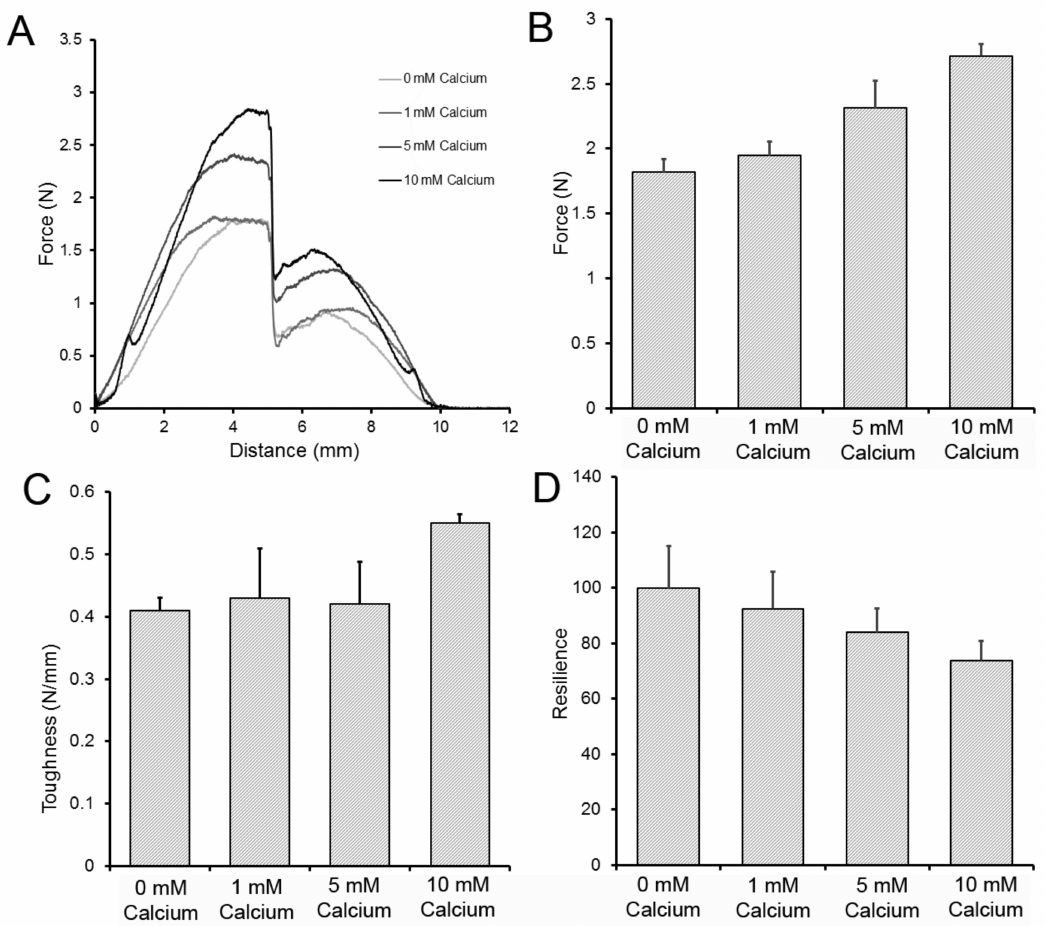
Figure 5. E ff ect of the calcium concentration on LMP film 3-point bend testing. ( A ) Representative 3-point bend tracings of LMP films with 0, 1, 5, and 10 mM calcium concentrations. ( B ) The peak force required for 5 mm blade displacement was significantly greater in LMP films with 5 and 10 mM calcium concentrations ( p < 0.001). ( C ) Toughness, here measuring the resistance to deformation, was significantly greater in the 10 mM calcium films ( p < 0.01). ( D ) The resilience, reflecting the ratio of the work of displacement and its corresponding stored energy, demonstrated that the resilience of 0 mM calcium films was significantly greater than that of the 10 mM calcium film ( p < 0.01). Error bars = 1